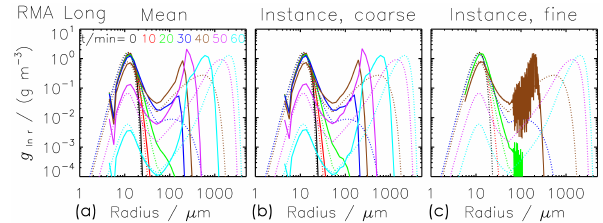
Figure 7. Mass density distributions obtained by RMA for the Long kernel from t 0 to 60min every 10min (from black to cyan; see = legend). The dotted curves show the reference solution; the solid curves show the simulation results of RMA with the reduction lim- iter ( e γ 0 . 1), weak threshold η 10 − 8 , (cid:49)t 0 . 1s and κ 40. = = = = The left panel shows the average over 50 realisations and the middle panel one specific realisation. For both, the bin resolution of the vi- sualisation is by default κ plot 4. The right panel shows again the = κ . specific realisation (only t 20 and 40min) but for κ plot = =